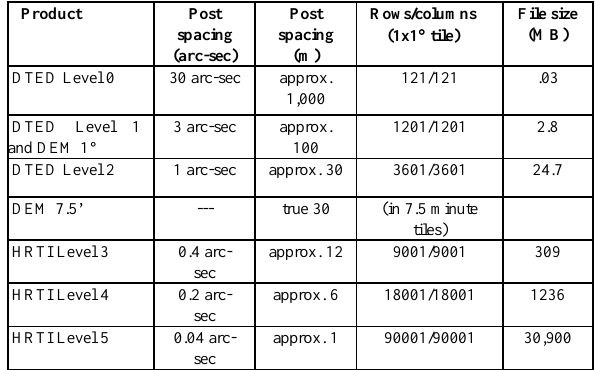
Table 2. NGA/NIMA and USGS Digital Elevation